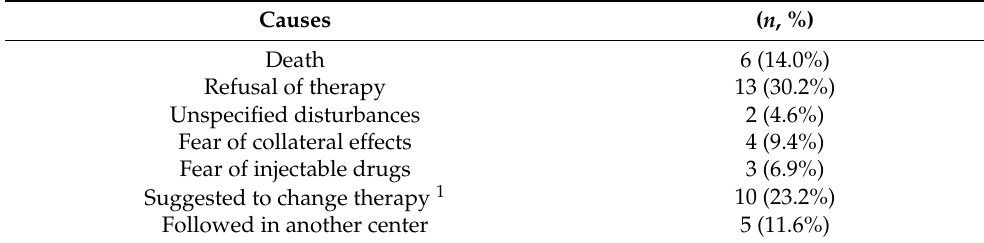
Table 2. Causes of dropouts ( n = 43/428, 10.04%).